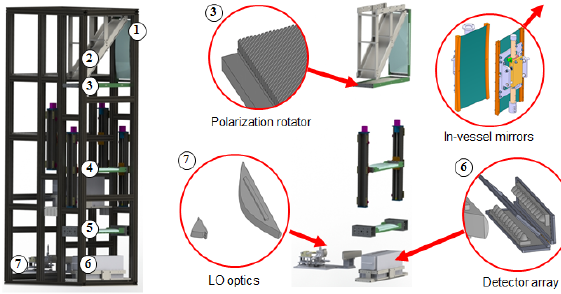
Fig. 6. Optical enclosure:  entrance lens,  45° mirror,  polarization rotator,  focusing lens (moveable), collimation lens,  detector array box  LO